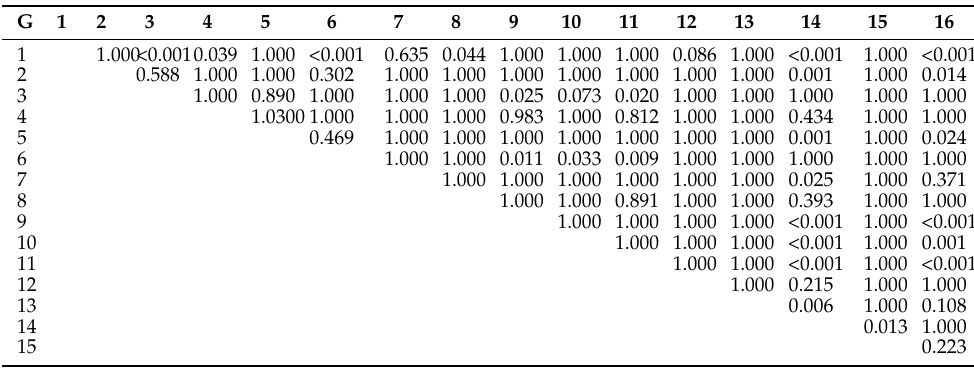
Table 4. Direct comparison between all the 16 groups ( p